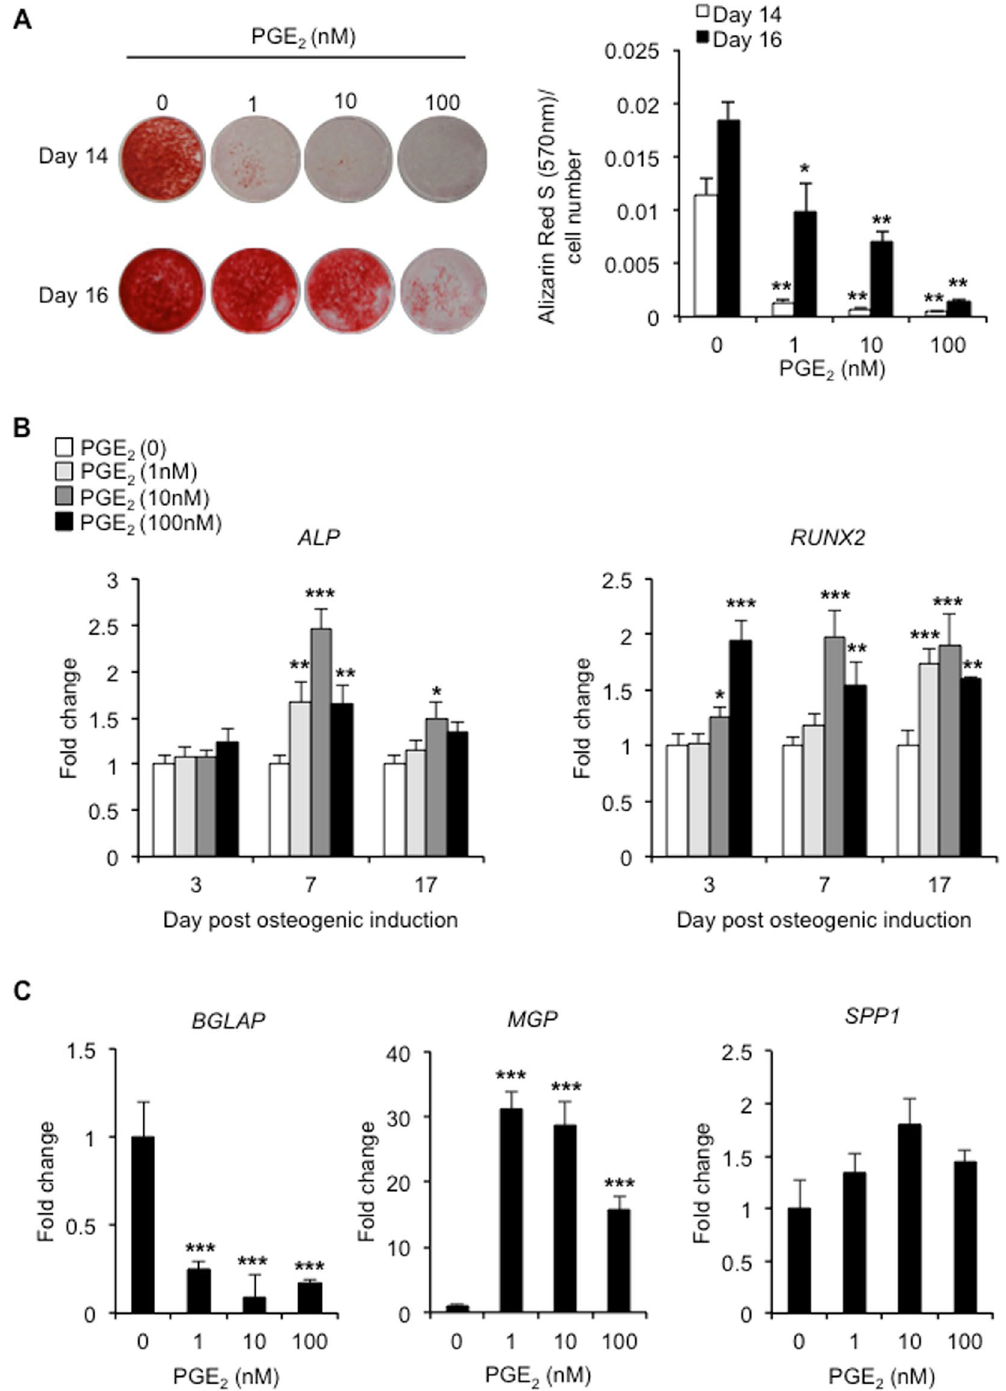
Figure 1. PGE 2 inhibits hBMSC-mediated matrix mineralization. ( A ) Alizarin Red S staining was used to assess the influence of continuous PGE 2 treatment on matrix mineralization in hBMSC cultures at 14 and 16 days post-osteogenic induction. * p < 0.01, ** p < 0.001 as compared to untreated hBMSCs using ANOVA. ( B , C ) RT-qPCR was used to determine expression levels of osteogenic differentiation markers RUNX2 and ALP at day 3, 7 and 17 post-osteogenic induction ( B ), and markers of osteoblast maturation and/or matrix mineralization BGLAP , MGP and SPP1 at day 17 post-osteogenic induction ( C ). Data were normalized to GUSB and expressed as fold change as compared to non-induced controls at day 0 (value 1) using the comparative C T method. * p < 0.05, ** p < 0.01, *** p < 0.001 as compared to untreated hBMSCs using ANOVA. The data represent triplicate determinations and were replicated at least two times. All values are presented as mean ±